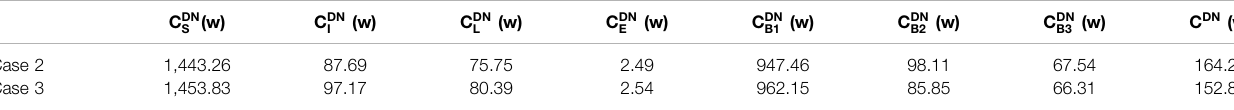
TABLE 6 | Costs, bene fi ts, and net income of DN company.